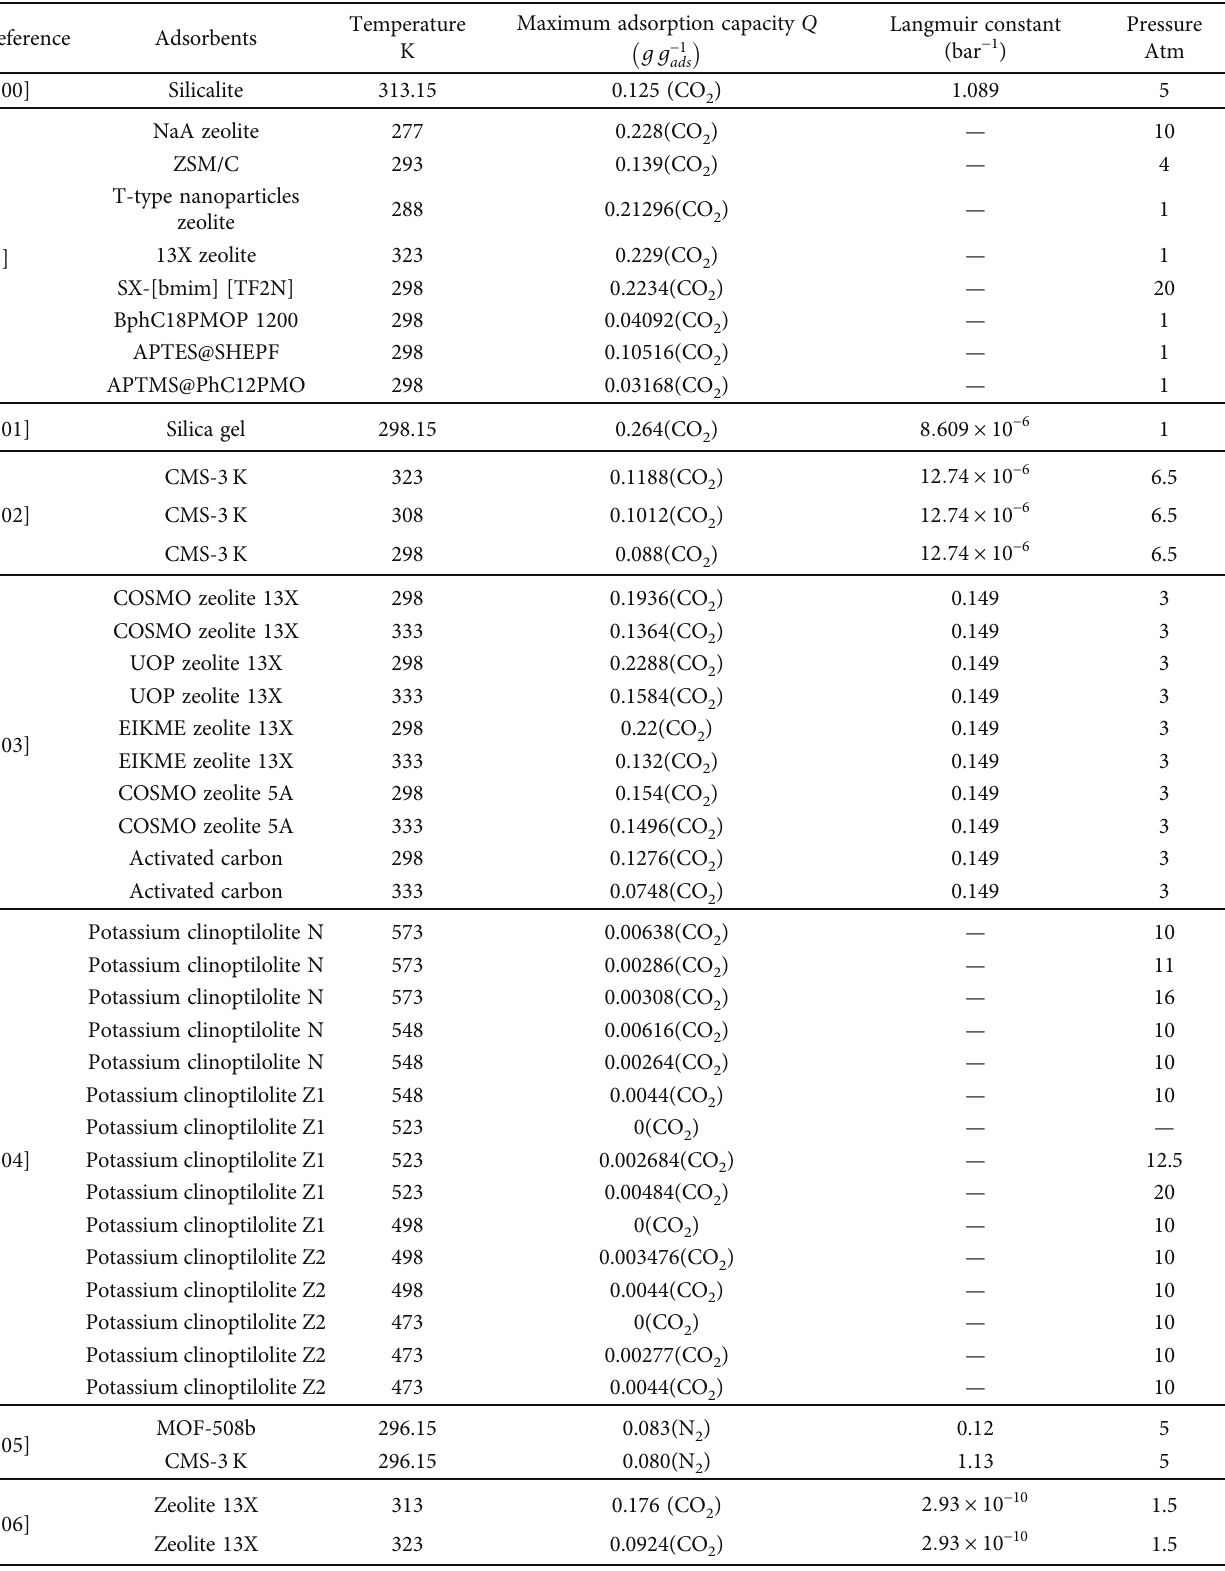
Table 20: Comparison of the thermodynamic values of various adsorbents as a function of di ff erent temperatures and